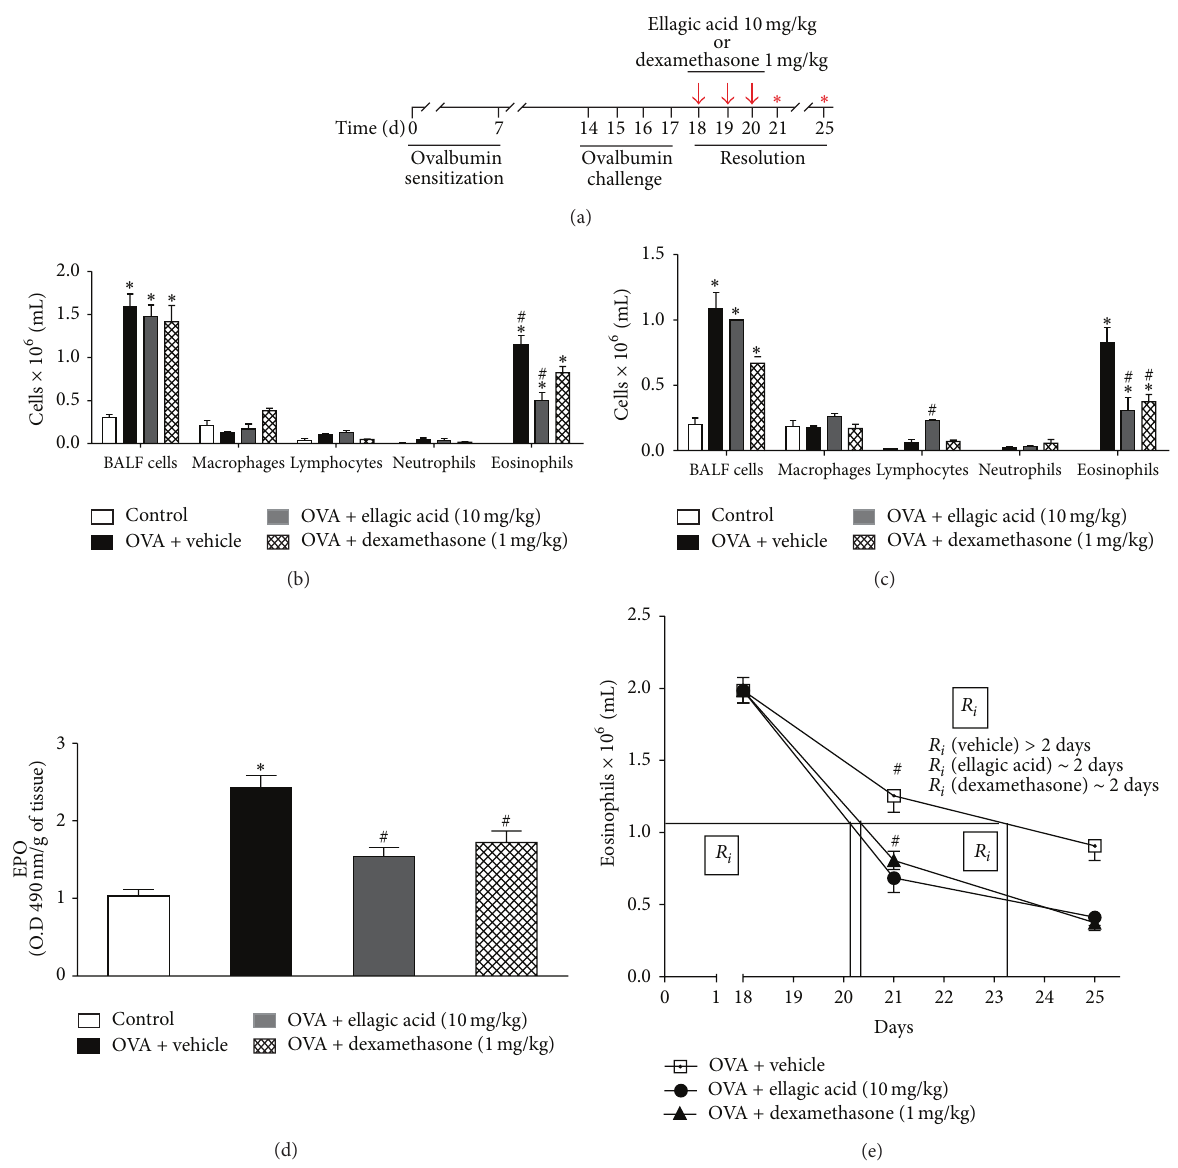
Figure 2: Ellagic acid demonstrates therapeutic anti-inflammatory activity on the resolution phase in the experimental airways allergic inflammation model. Mice received ellagic acid (10mg/kg, p.o.), dexamethasone (1mg/kg, s.c.), or vehicle (water, p.o.) after ovalbumin challenge at 18, 19, and 20 days (see Section 2) and were euthanized on 21 or 25 days and cells in bronchoalveolar lavage were counted (a). BALF cells and leukocytes subset at 21 days (b); BALF cells and leukocytes subset at 25 days (c). One group of animals received vehicle (p.o.) only (control group). EPO concentration in the lung at 21 day (d). The resolution interval ( 𝑅 𝑖 ) (e). Results represent the mean ± SEM, of two or more independent experiments with four mice per group per experiment. ∗ 𝑃 < 0.05 compared with control group; # 𝑃 < 0.05 compared with ovalbumin + vehicle